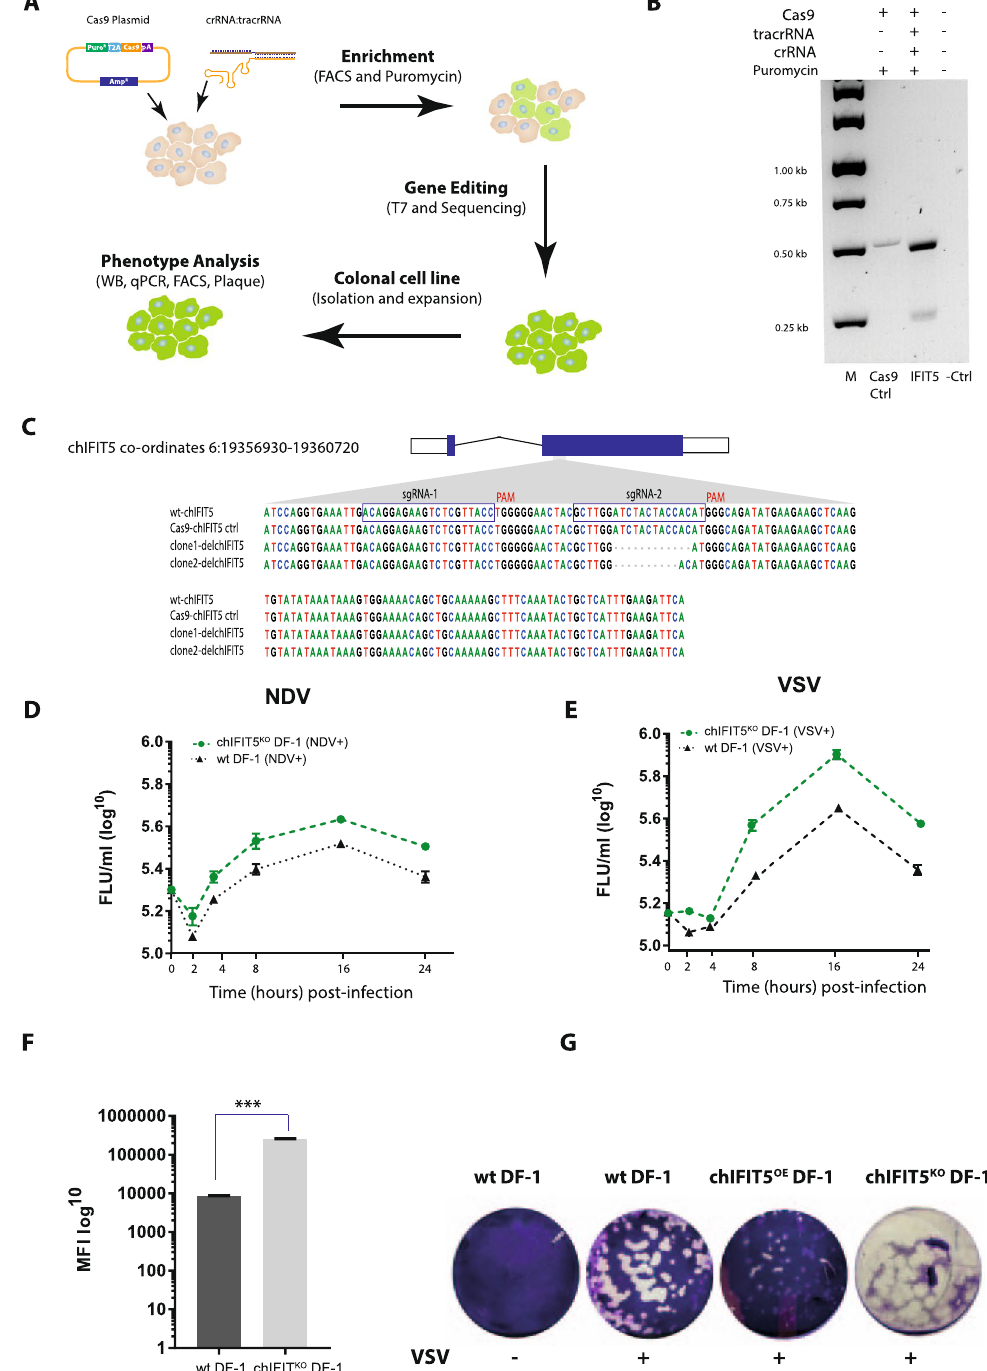
Figure 6. Knockout of chIFIT5 gene from chicken fibroblasts using CRISPR/Cas9 genome editing technology and evaluation of the influence of chIFIT5 on the replication of NDV and VSV. ( A ) DF-1 cells were co- transfected with hybridized crRNA and tracrRNA and plasmid expressing both Cas9 and puromycin resistance gene. 48 hours post-transfection; cells were passaged and selected with puromycin (10 ug/ml) until complete death of non-transfected cells. Puromycin-resistant cells were transfected with GFP expressing plasmid and were FACS sorted into individual cells and expanded until desire number of cells was achieved. At least 5 clones were confirmed for editing before clonal expansion and phenotypic analysis. ( B ) T7EI assays confirmation of the InDels in clonal cells that were supplemented with all essential components of gene editing including crRNA, tracrNA and Cas9 (lane number 3) compared to Cas9 control (lane number 2) and a no-input control (lane number 4). ( C ) Confirmation of gene editing using DNA sequencing of amplicons spanning the putative InDels site. ( D , E ) Wild type and chIFIT5 KO -confirmed DF-1 cells were infected with NDV ( D ) or VSV ( E ). Replication of RNA viruses was monitored for 24 hours of post-infection and shown in fluorescent units. ( F